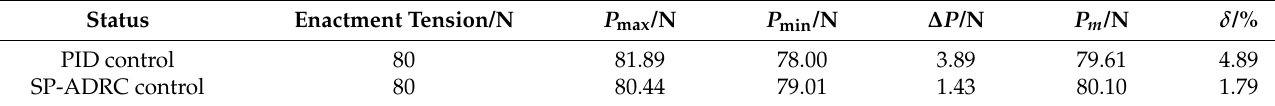
Table 2. The static difference rate of